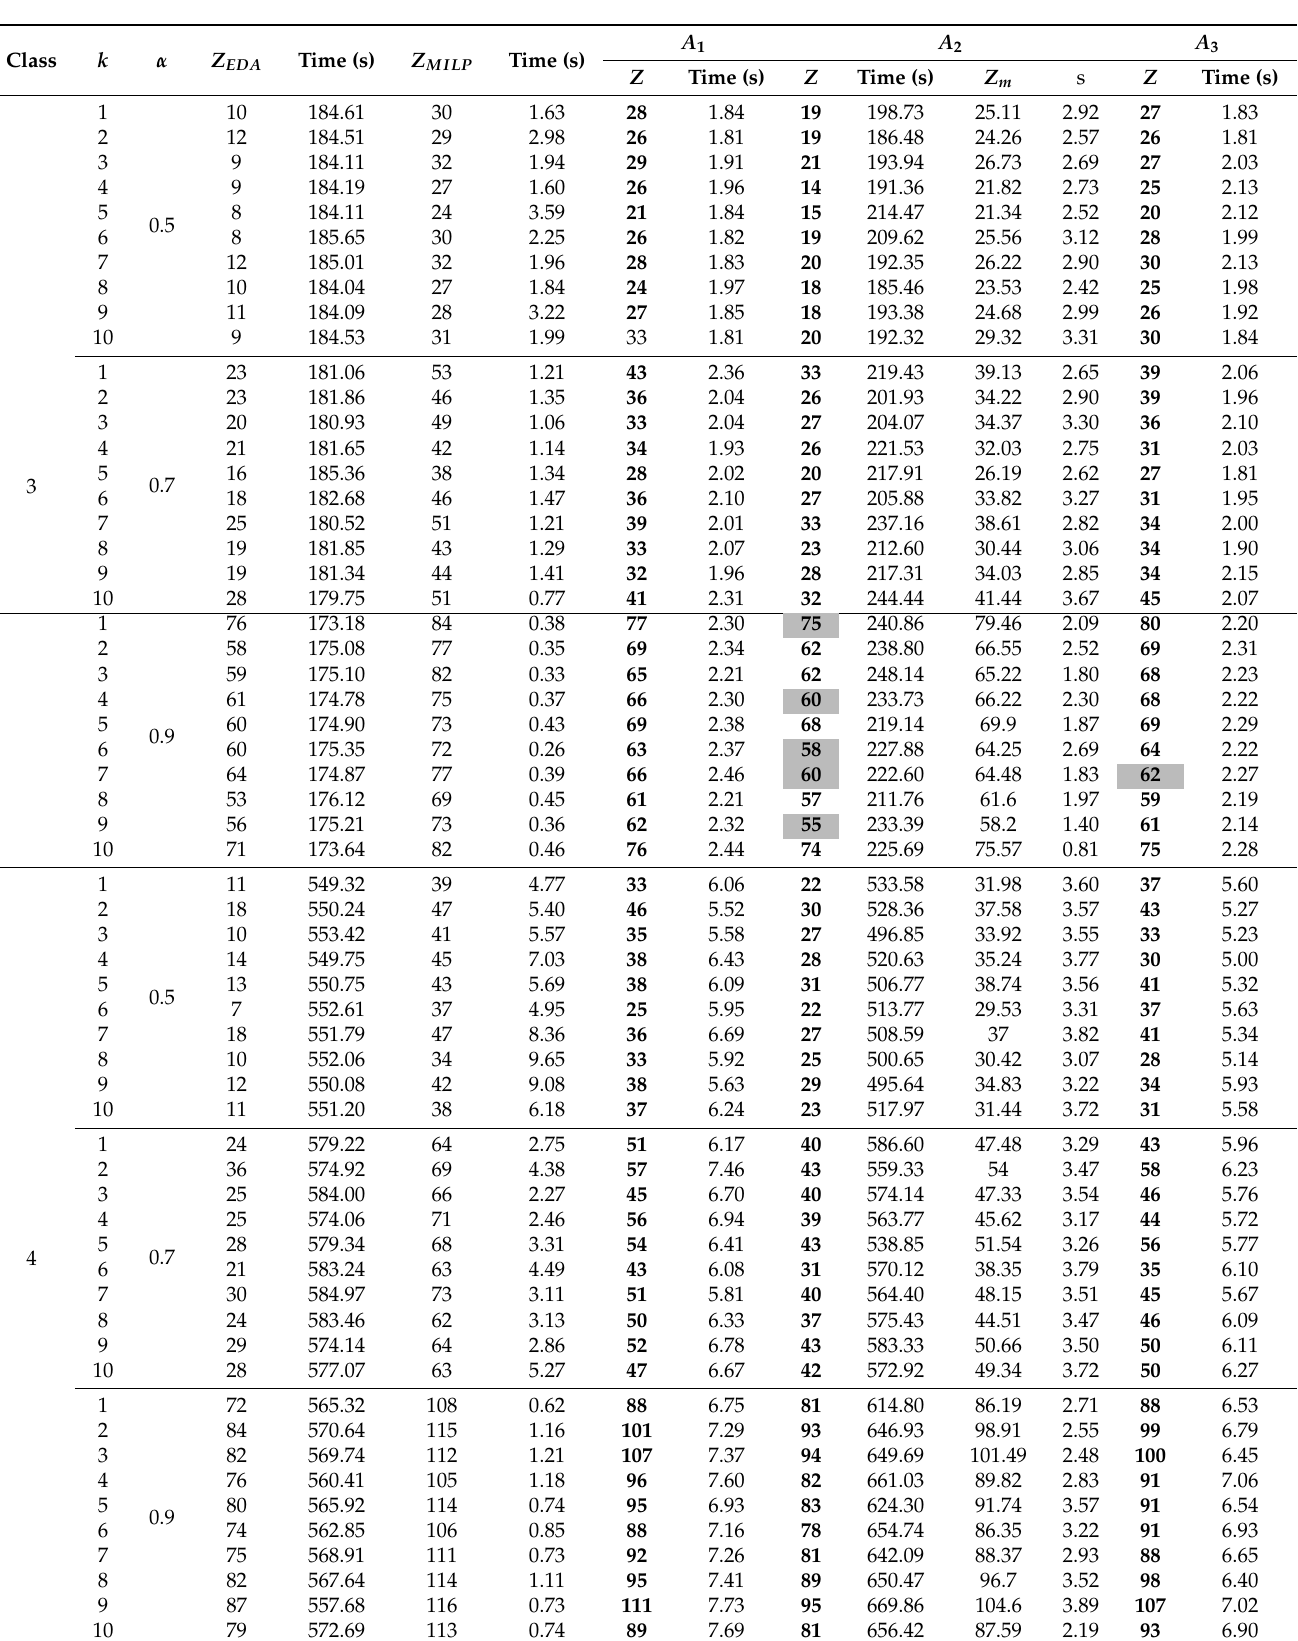
Table 4. Results of class 3 and class 4